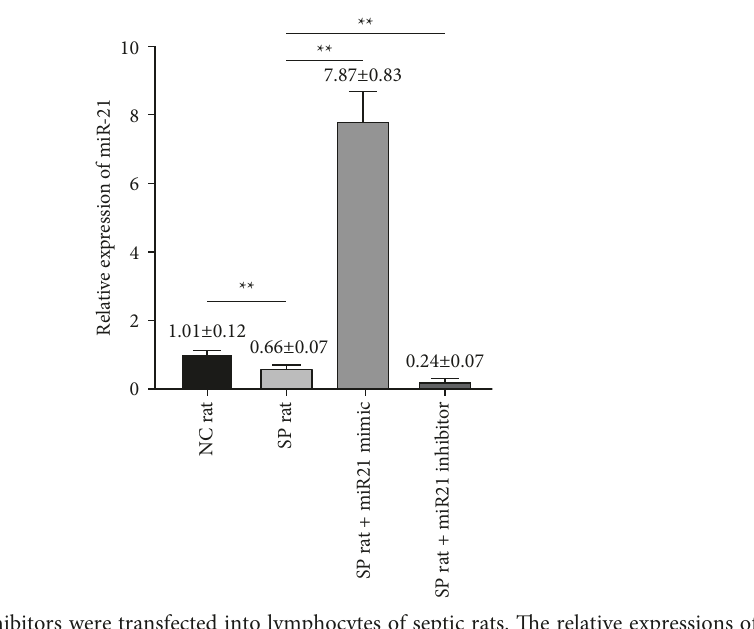
Figure 4: miR-21 activators and inhibitors were transfected into lymphocytes of septic rats. The relative expressions of miR-21 in eight- paired NC rat group, SP rat group, SP rat +miR21 mimic group, and SP rat+miR21 inhibitor group were determined by real-time quantitative PCR [ t value (NC versus SP) � 5.436, p < 0.01; t value (miR-21 mimic versus SP) � 23.988, p < 0.01; t value (miR-21 inhibitor versus SP) � 18.393, p < 0.01]. NC group: normal control group; SP group: sepsis group. SP rat+miR21 mimic group: sepsis group with miR- 21 activator transfected into lymphocytes; SP rat +miR21 inhibitor group: sepsis group with miR-21 inhibitor transfected into lymphocytes. ∗∗ p <